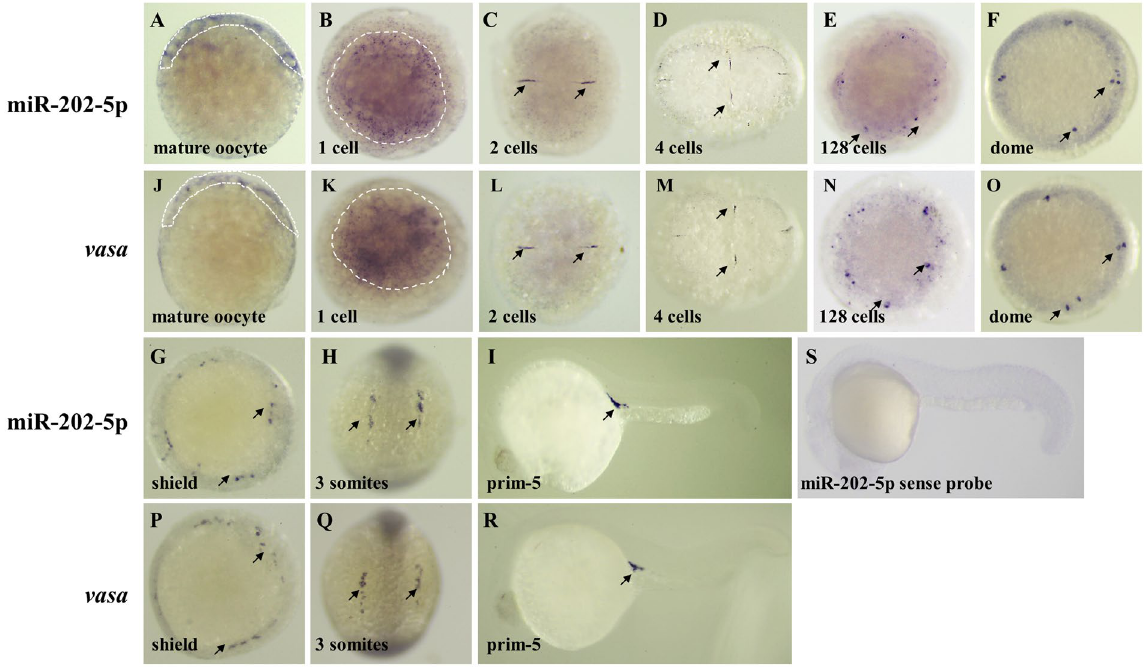
Figure 3. Spatial and temporal localization of miR-202-5p in mature oocytes and embryos at different development stages by WISH. A-I, localization of miR-202-5p; J-R, localization of vasa mRNA; S, negative control. The black arrows indicated the positive signals of miR-202-5p and vasa mRNA.